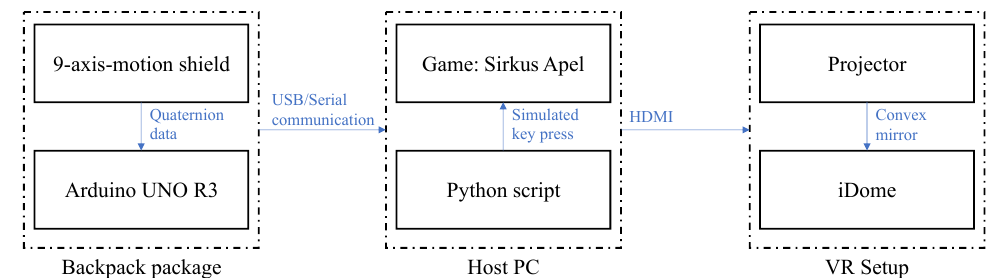
Figure 6. The back-controller diagram block related to Host-PC and the VR iDome device.